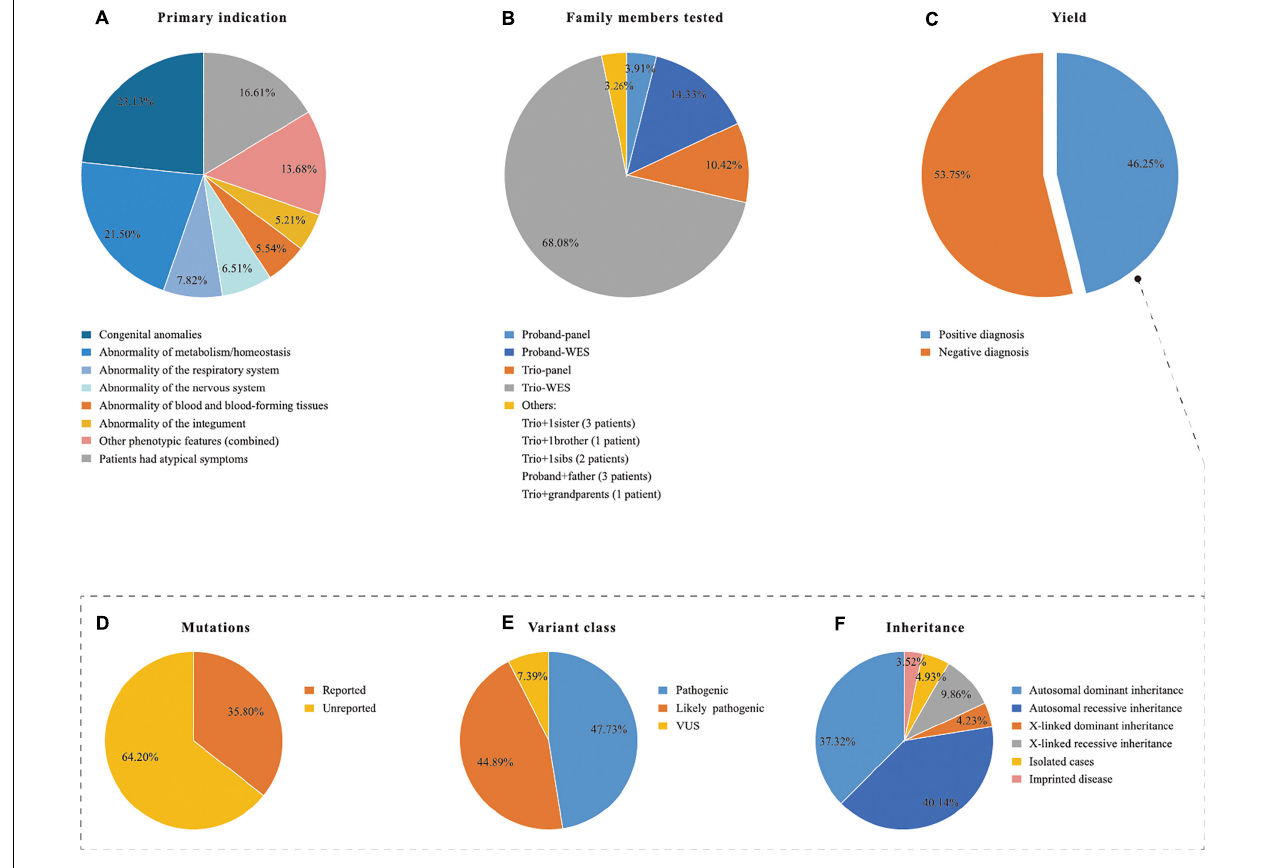
FIGURE 2 | Descriptive statistics of the patient cohort and the positive NGS cases. NGS, next generation sequencing; TES, Targeted exome sequencing; WES, whole exome sequencing; VUS, variants of unknown clinical significance. (A) Primary indication, (B) family members tested, (D–F) in the dotted box explain the positive yield indicated in (C) in